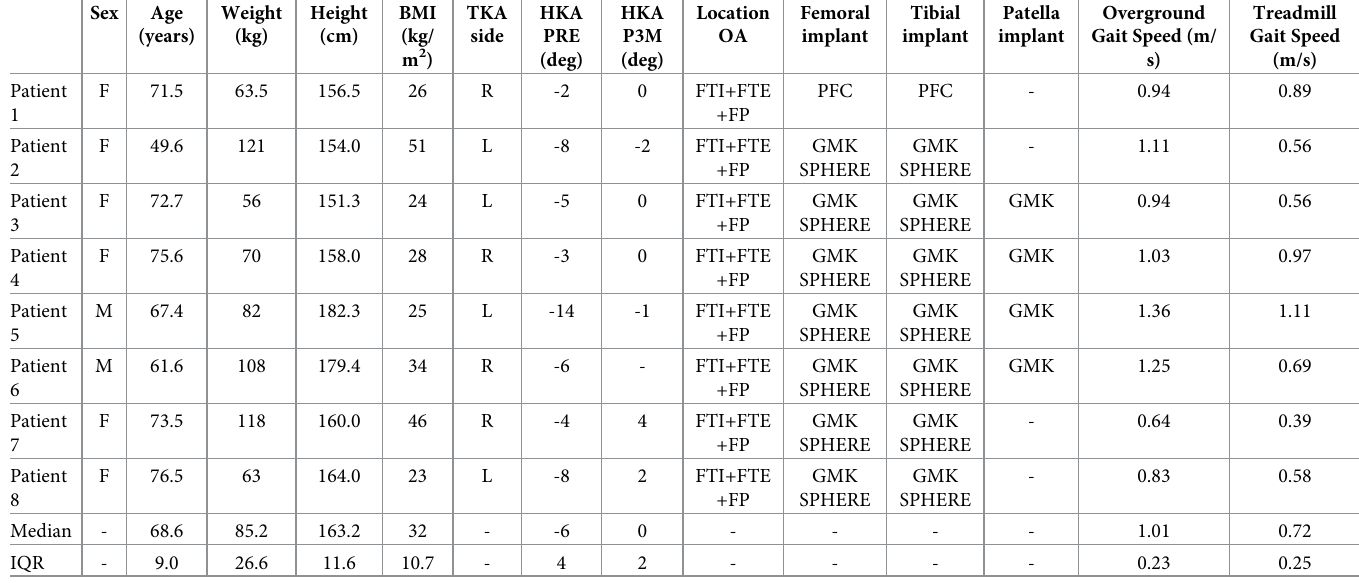
Table 1. Patient characteristics, the Hip Knee Ankle (HKA) angle was noted as positive for adducted knees (valgus) and negative for abducted knees (varus). PRE = pre-surgery; P3M = three months post-surgery.